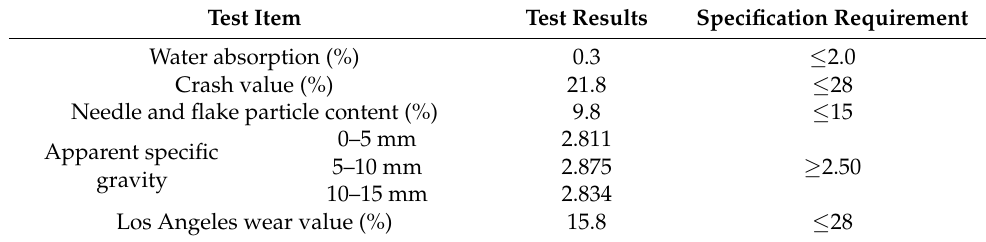
Table 1. Physical and technical properties of the coarse aggregates.